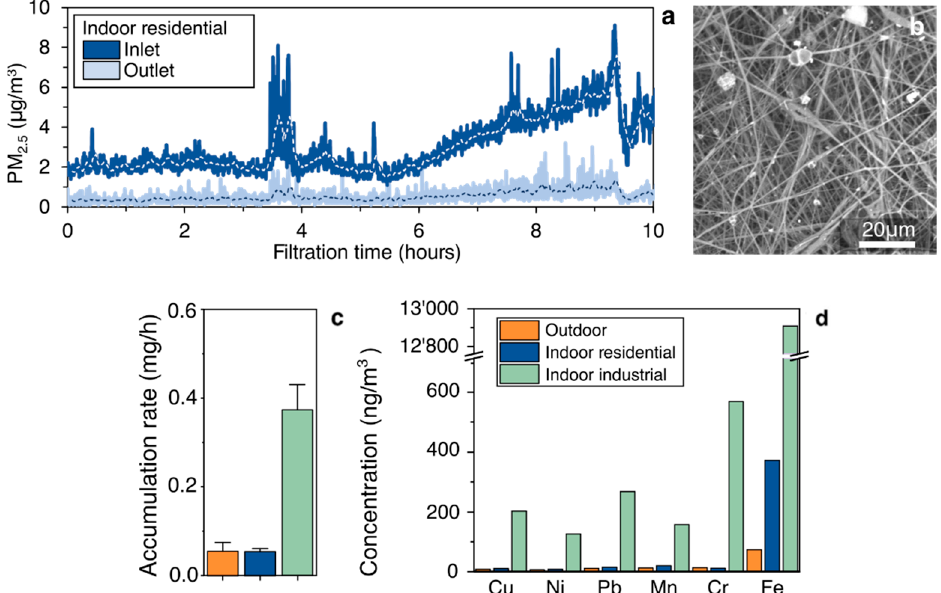
Figure 4. ( a ) Concentration of PM 2.5 before and after 10 h of continuous single-PLA filtration; ( b ) SEM images of the electrospun mat after filtration; ( c ) accumulation of particulate over the filter, obtained by gravimetric analysis; ( d ) concentrations of metals in three different environments: outdoors, indoors residential, and indoors industrial.